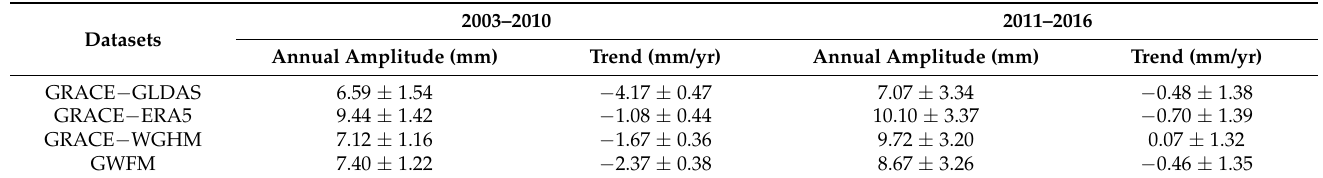
Table 3. Comparison of annual amplitude and trend between GWSA from GRACE − GLDAS, GRACE − ERA5, GRACE − WGHM, and GWFM.